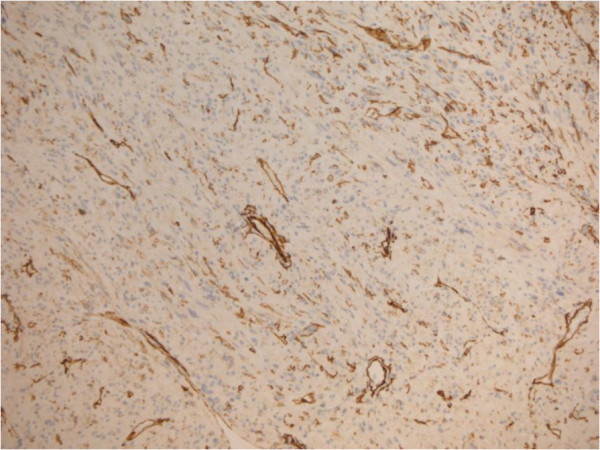
Immunostain for CD34: focal immunoreactivity.